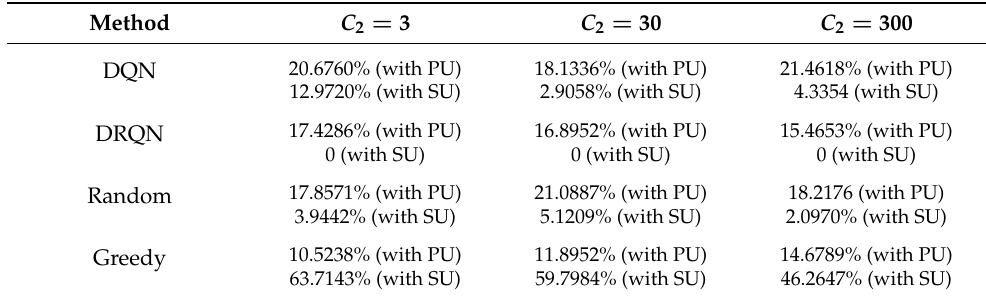
Table 5. The collision rate after 200,000 steps under different C 2 (multiple SUs).